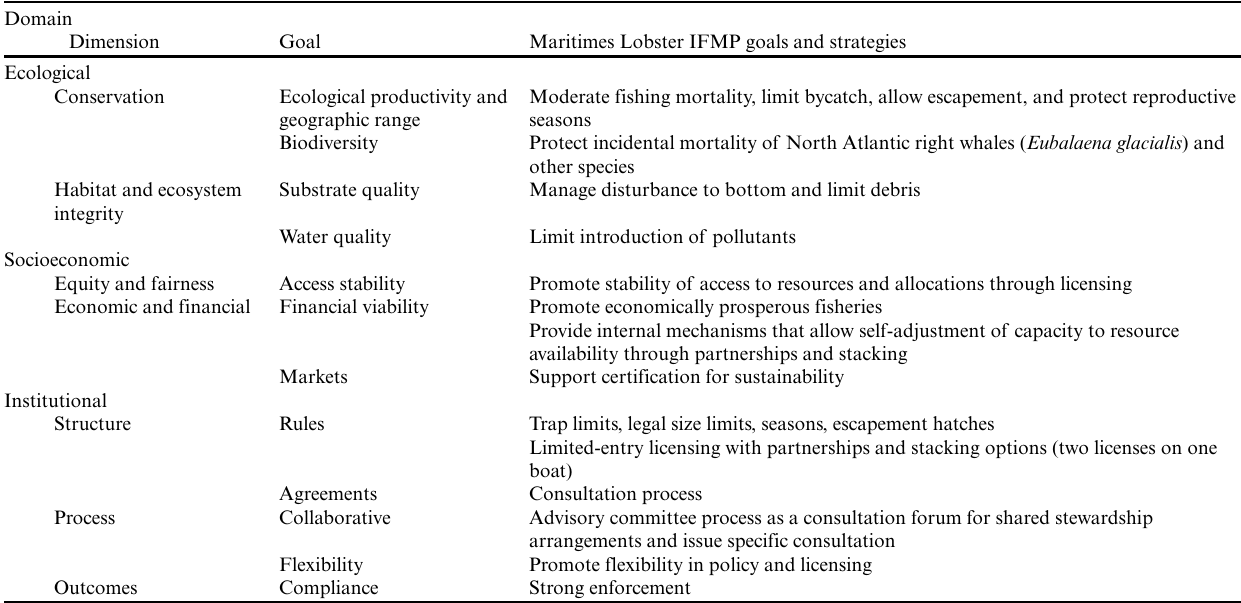
Table 1 . Summary of ecological, socioeconomic, and institutional goals and strategies of the Maritimes lobster Integrated Fisheries Management Plan